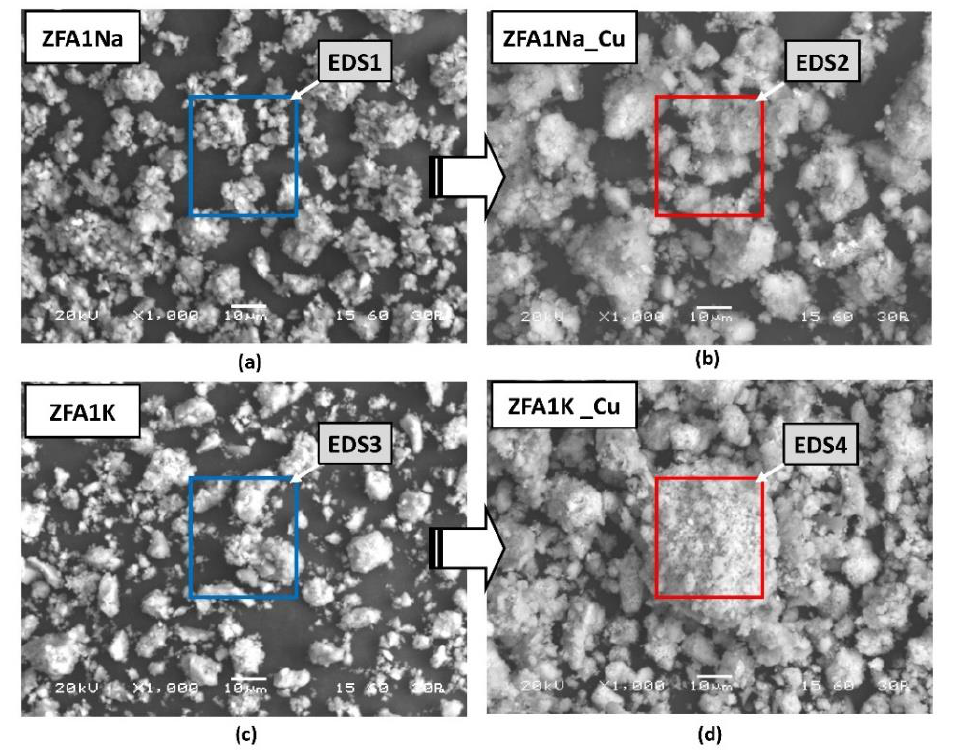
Figure 8. Comparison of morphology obtained for synthetic zeolites ZFA1Na and ZFA1K based on SEM / EDS analyses prior to (( a ) ZFA1Na and ( c ) and ZFA1K) and after removal (( b ) ZFA1Na_Cu and ( d ) ZFA1K_Cu) of Cu(II) ions. Concentration, 200 mg · L − 1 ; zeolite dosage, 0.5 g · L − 1 . EDS analyses were performed on the square highlighted regions (1–4).